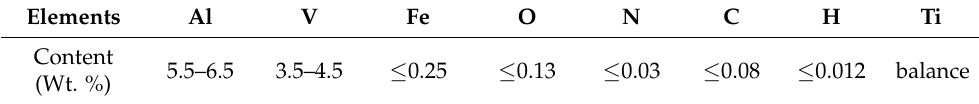
Table 1. Chemical components of Ti6Al4V powder used in the SLM process.